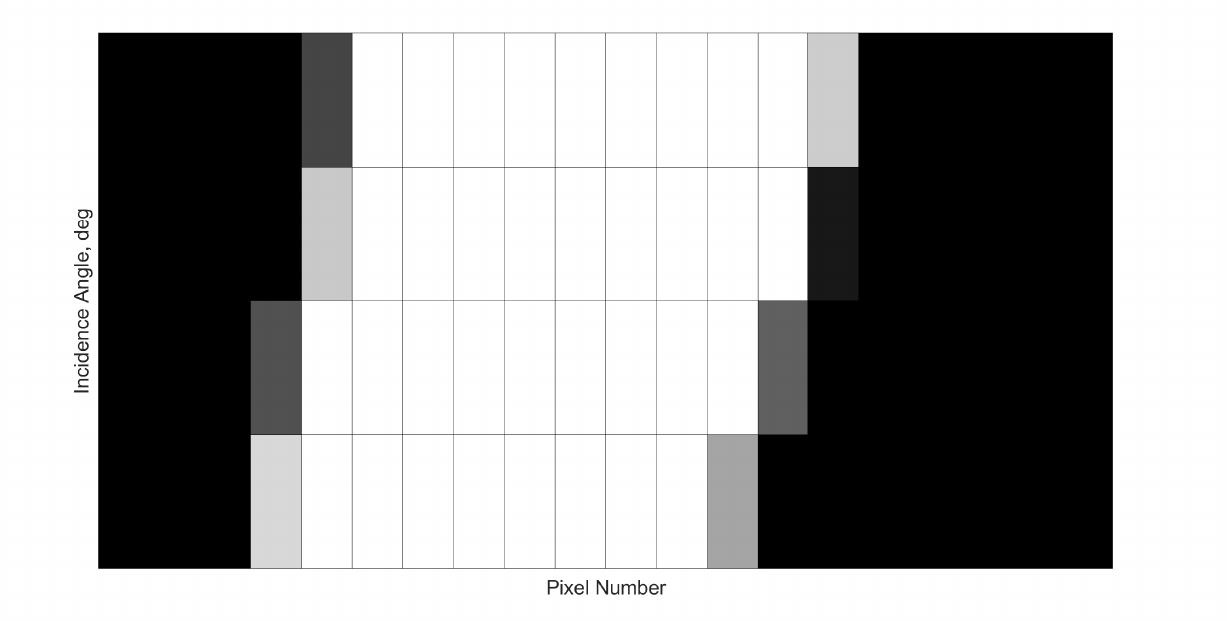
Figure 4. Sweep of expected pixel response at incidence angles ranging from − 52.5 through to 52.5 degrees. Illuminated pixels are highlighted in white.